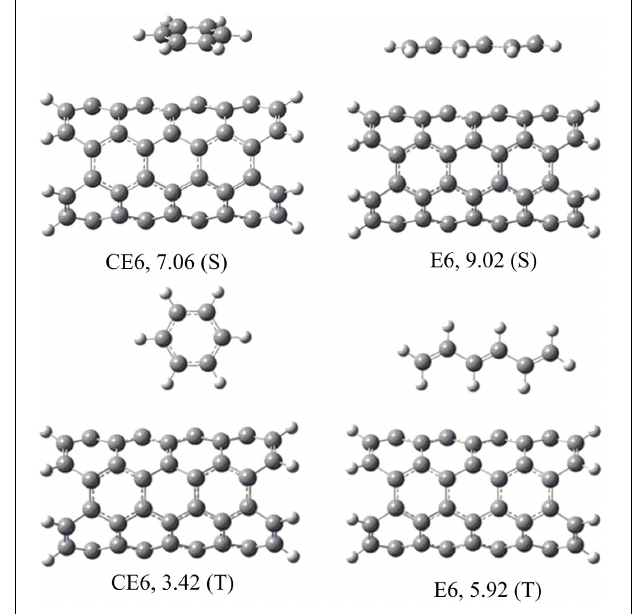
FIGURE 4 | Possible orientations (S and T) of the unsaturated hydrocarbons on CNSs and their binding energies (kcal/mol).